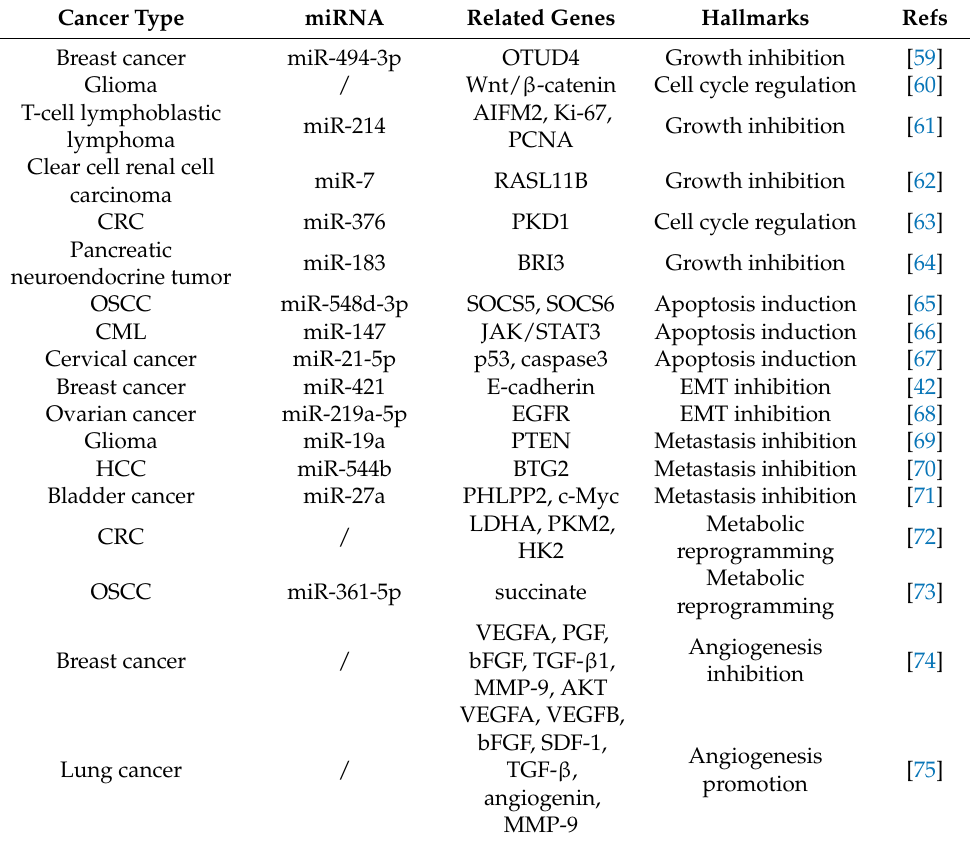
Table 1. Biological implications of MEG3 on hallmarks of